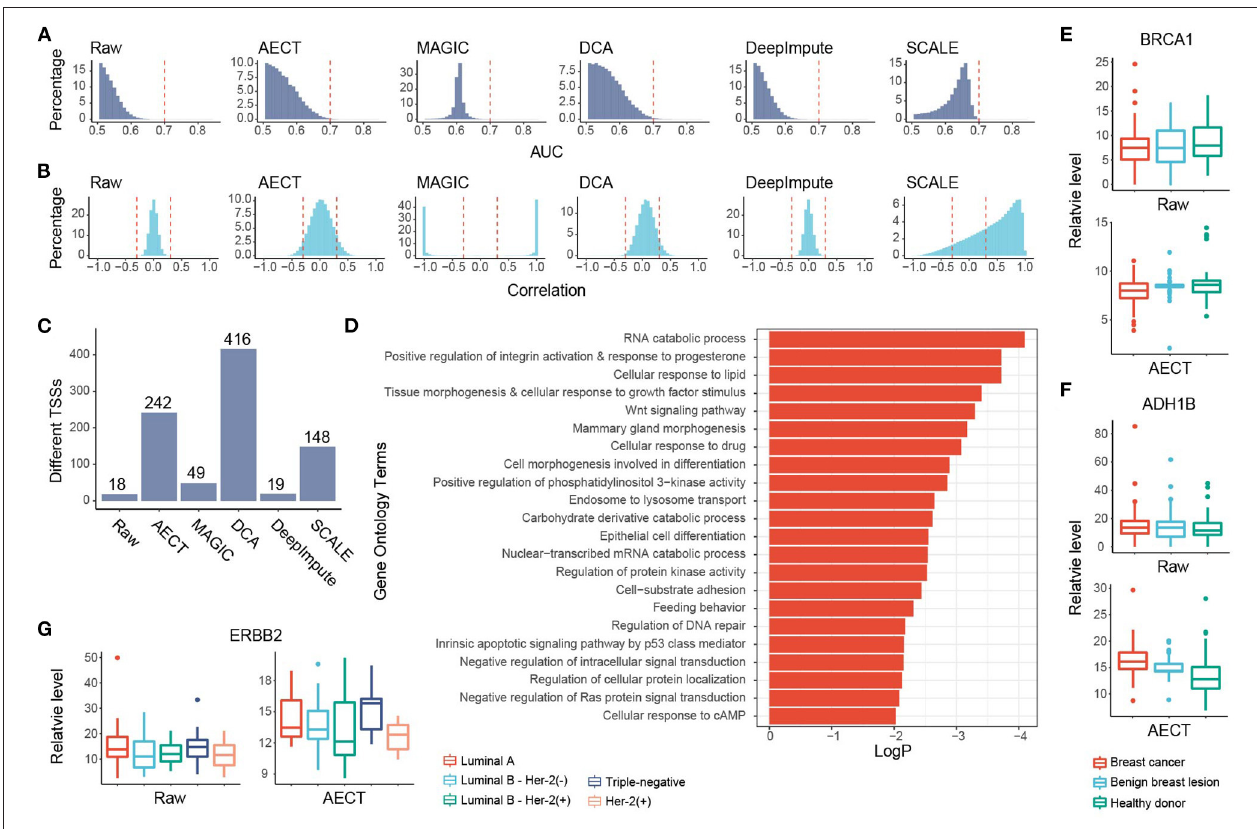
FIGURE 4 | Imputation performance of AECT and other algorithms on breast cancer. (A) AUROC patterns for each TSS in breast cancer detection; dashed lines represent AUROC = 0.7. (B) Correlation patterns between TSSs; dashed lines represent Pearson correlation coefficients r = ± 0.3. (C) Breast cancer-associated TSSs (FDR < 0.1, Wilcoxon rank-sum test adjusted by Holm procedure) identified with different algorithms. (D) Gene Oncology enrichment of sex-different TSSs identified by AECT. (E,F) TSS coverage of (E) BRCA1 and (F) ADH1B in breast cancer, benign breast lesion, and healthy donor group (significant differences between breast cancer and non-cancer samples, BRCA1 raw: p = 0.461; BRCA1 imputed by AECT, p = 0.0480; ADH1B raw: p = 0.327; ADH1B imputed by AECT, p = 3.23 × 10 − 6 ; Wilcoxon rank-sum test). (G) TSS coverage of ERBB2 in different breast cancer subtypes (for ERBB2 raw and ERBB2 imputed by AECT, p = 0.0472, Kruskal–Wallis test; p = 0.0129, Wilcoxon rank-sum test between samples with and without Her-2 expression,